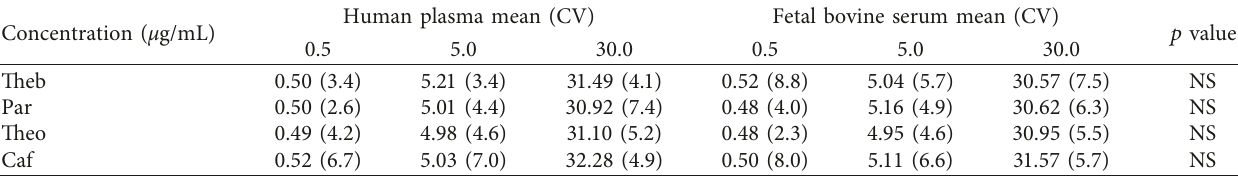
Table 3: Differences between concentrations of caffeine and metabolites in human plasma or fetal bovine serum spiked sample. Concentration ( µ g/mL)